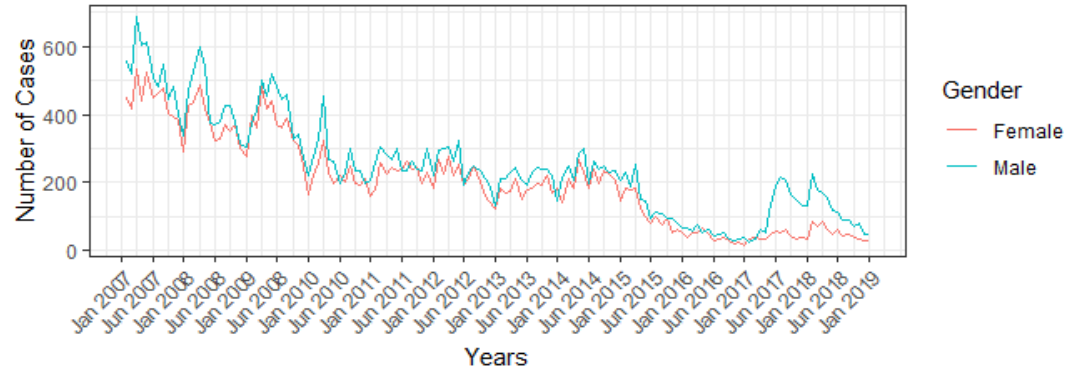
Figure 2. Hepatitis A reported cases in Brazil, by month and gender, from 2017 to 2018.